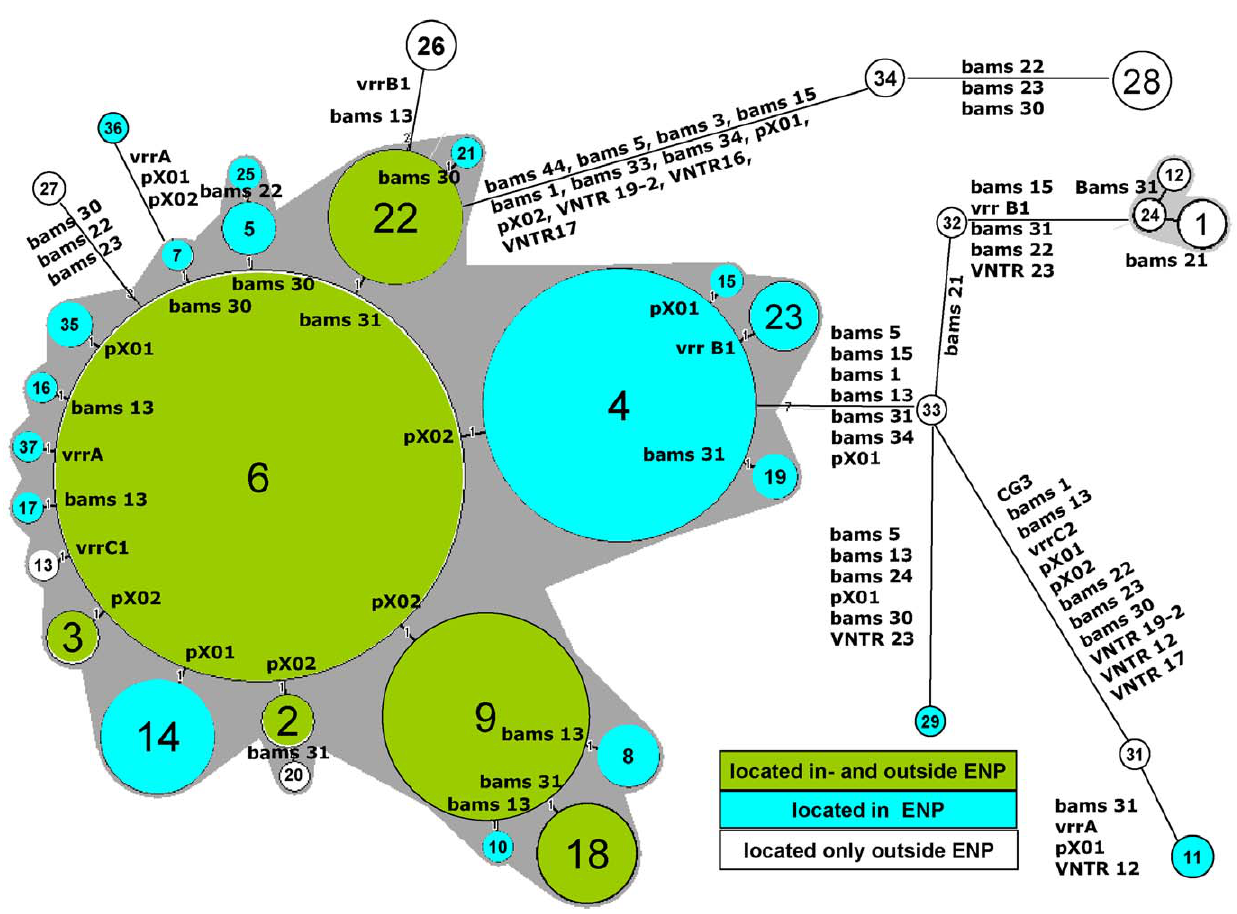
Figure 7. Minimum spanning tree of 377 Namibian isolates typed by MLVA. Clustering of MLVA profiles was done using a categorical coefficient. The MLVA-GTs are displayed as circles with the appropriate GT number. The size of each circle symbolizes the number of isolates of this particular GT. GTs differing in only one marker are combined in a complex seen as a gray halo if at least 3 GTs fulfill this criterion. The marker(s) on which the mutation is located is shown. Distances between circles do not reflect the correct phylogenetic distances. The vaccine isolates are not included. The relations within this tree remain the same if an outgroup like the B-cluster (as used in Figure S1) is included (not shown).